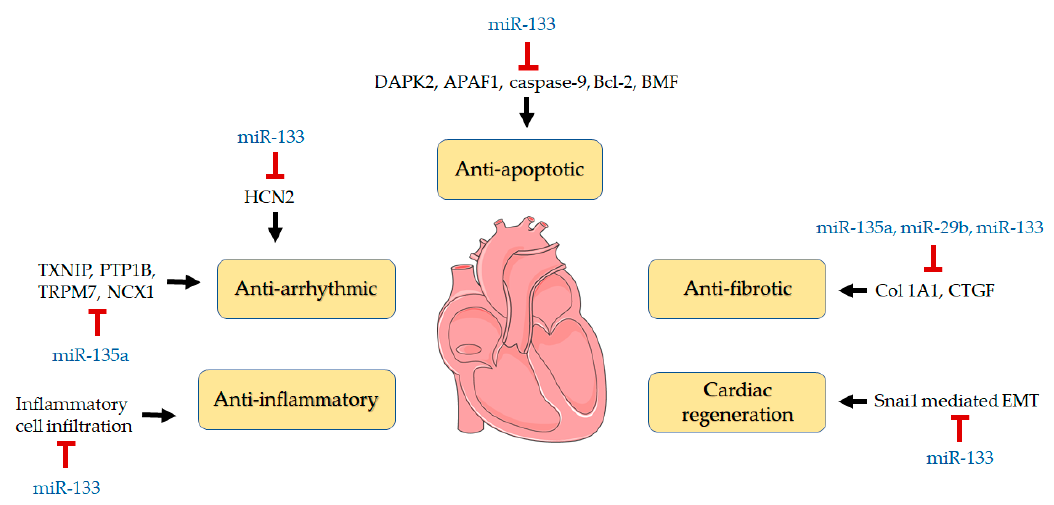
Figure 6. ALA-rich flaxseed oil upregulates the expression of miR-133a, miR-135a, and miR-29b and consequently exerts cardioprotective effect.